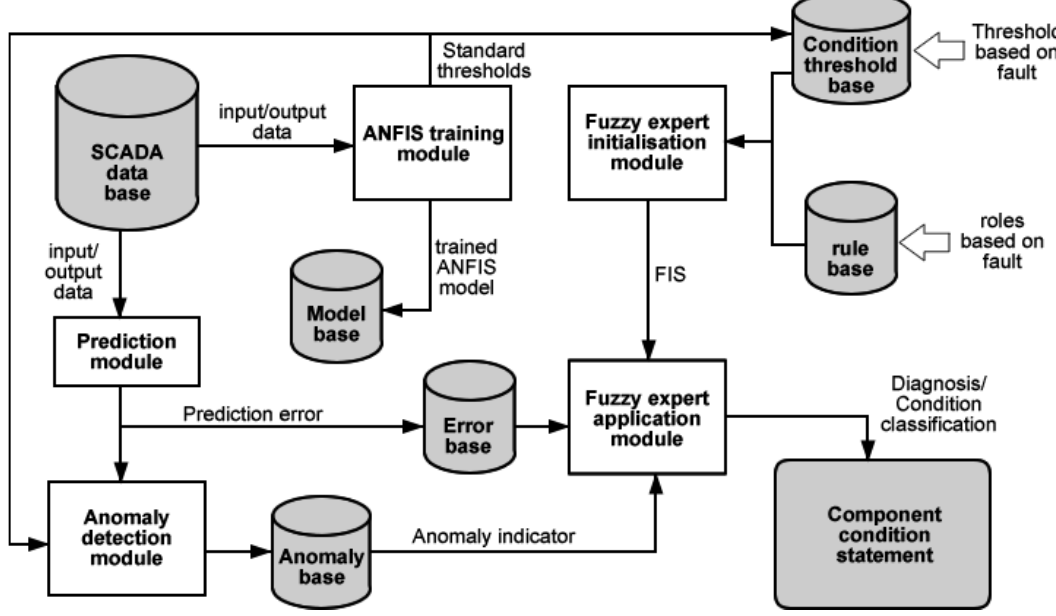
Figure 12. Overview of wind turbine condition monitoring (WTCM) based on supervisory control and data acquisition (SCADA) data analysis. FIS: fuzzy interference